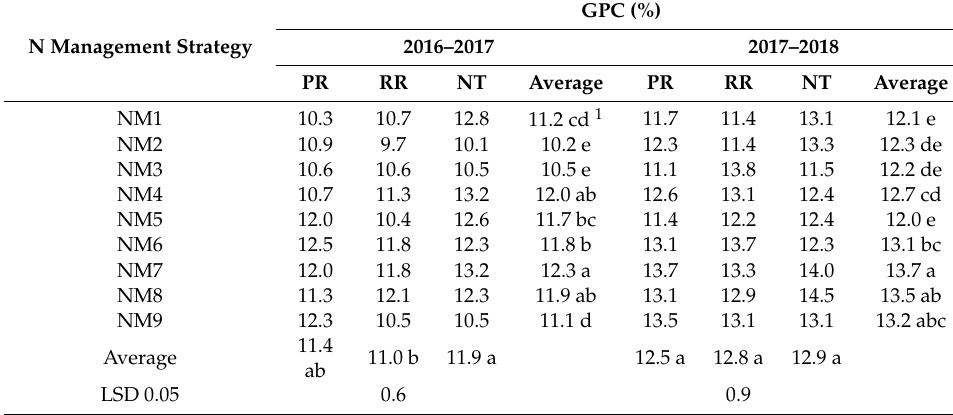
Table 5. GPC of wheat under various tillage methods and N management strategies.